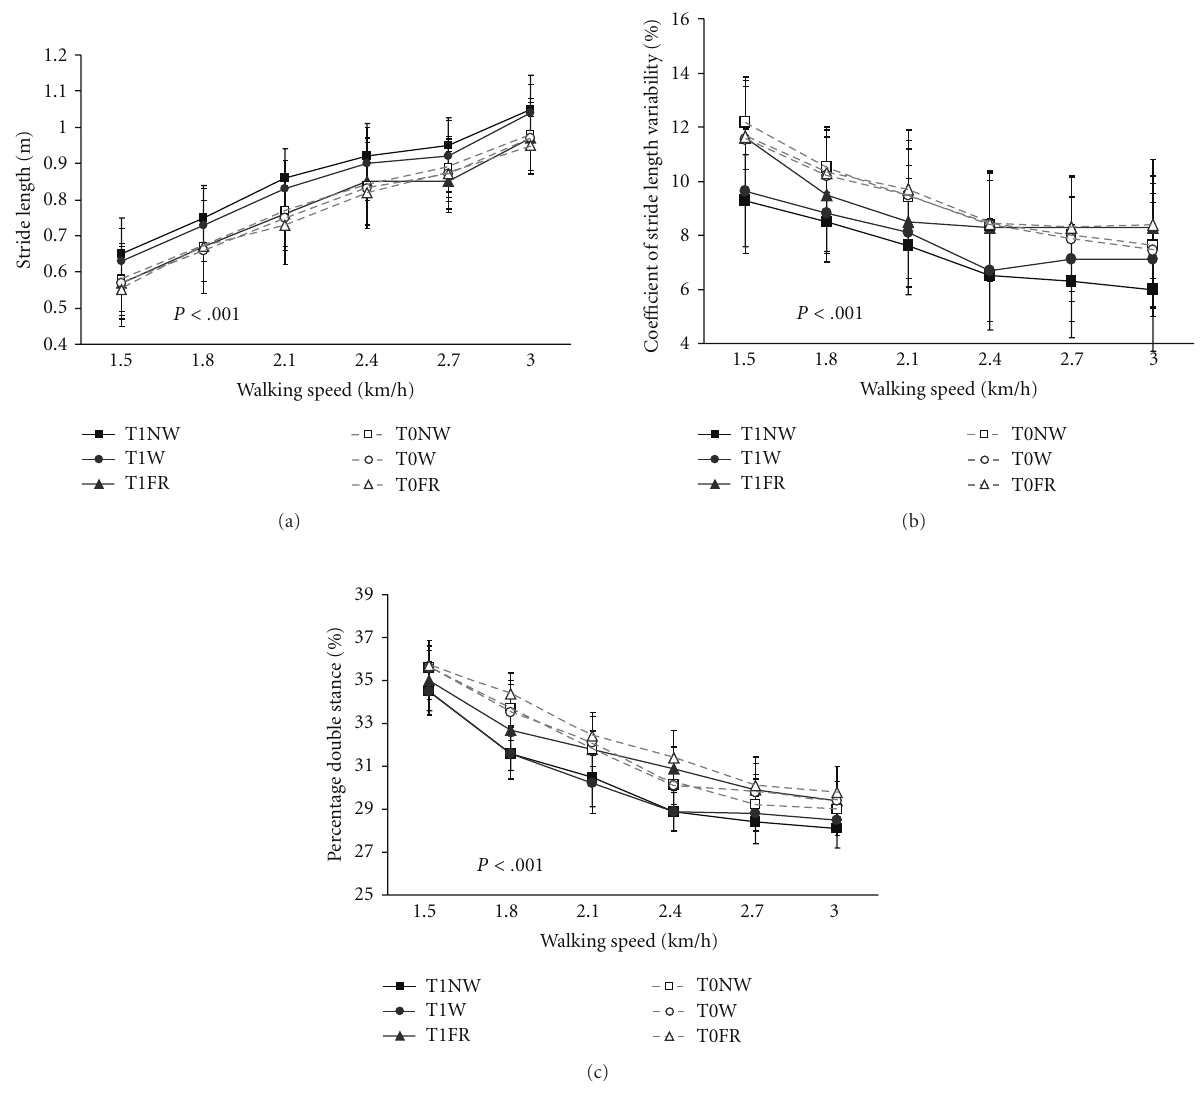
Figure 5: (a) Stride length increased significantly with increasing walking speed, and improved further on the second assessment ( P < . 001). Stride length improved significantly more in the Nordic walking and walking groups than in the flexibility and relaxation group ( P < . 001). T0 = first assessment; T1 = second assessment, error bars indicate the standard deviation. (b) Stride length variability improved most in the Nordic walking group. Nordic walking training was superior to walking ( P < . 01) and the flexibility and relaxation programme (F&R) ( P < . 001). T0 = first assessment; T1 = second assessment, error bars indicate the standard deviation. (c) The duration of the double stance phase decreased with increasing walking speed in all groups but significantly more in the Nordic walking and walking group ( P < . 001); T0 = first assessment, T1 = second assessment, error bars indicate the standard